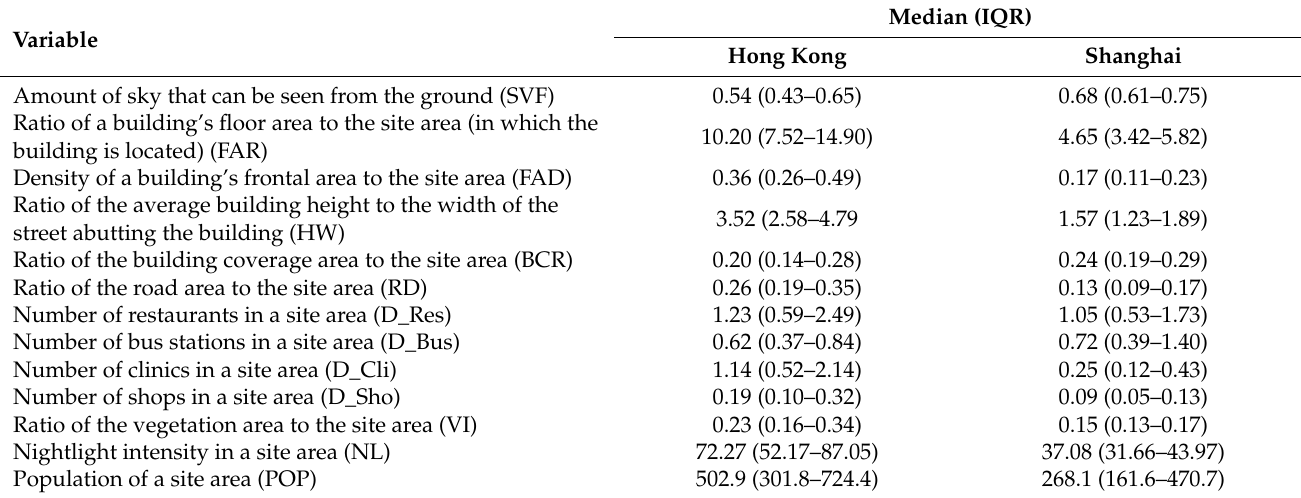
Table 1. Built-environment factors and their